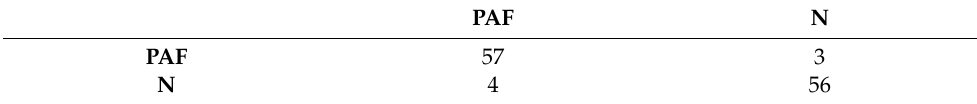
Table 6. Classification results of the prediction model in the AFPDB test set.